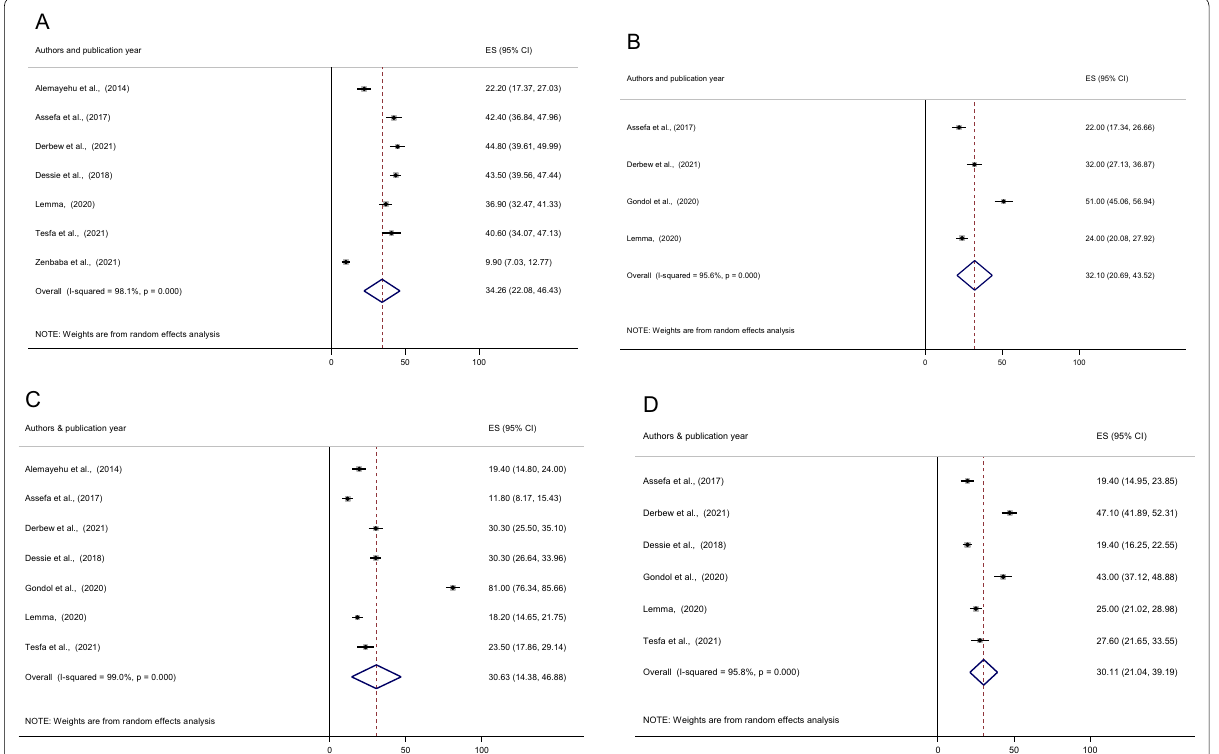
Fig. 4 Forest plot depicting the pooled prevalence of symptoms of computer vision syndrome among computer users; ( A Blurred vision, B Eyes Fatigue, C Watery eyes, D Burning sensation, E Headache, F Redness of the eyes, G Eyestrain, H Eye Irritation, I Dry eye, J Double vision) in